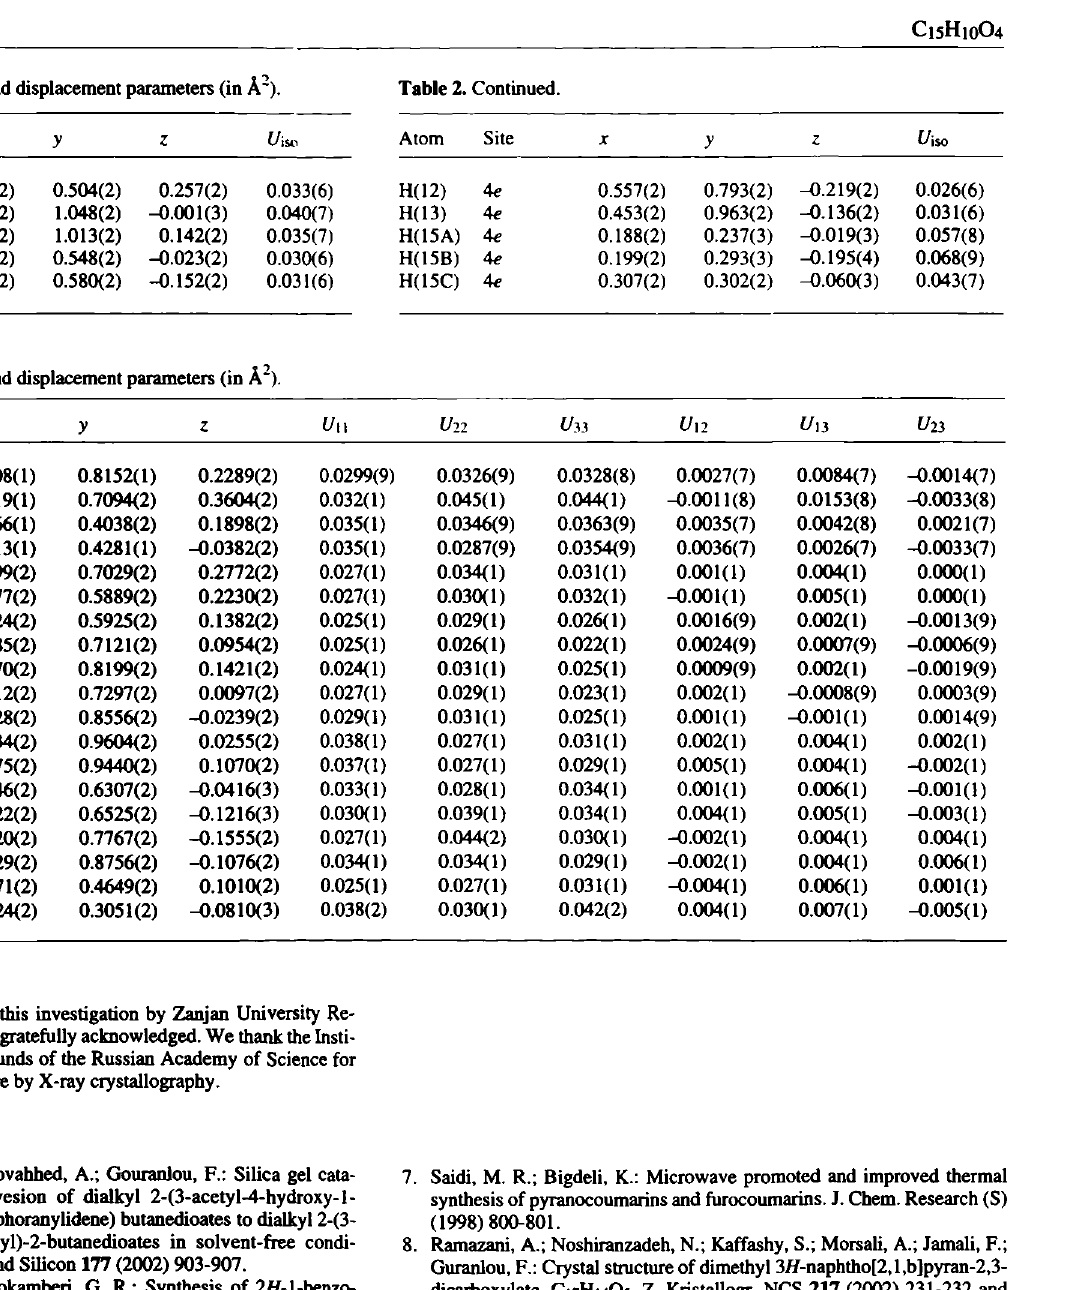
Table 2. Atomic coordinates and displacement parameters (in Â").